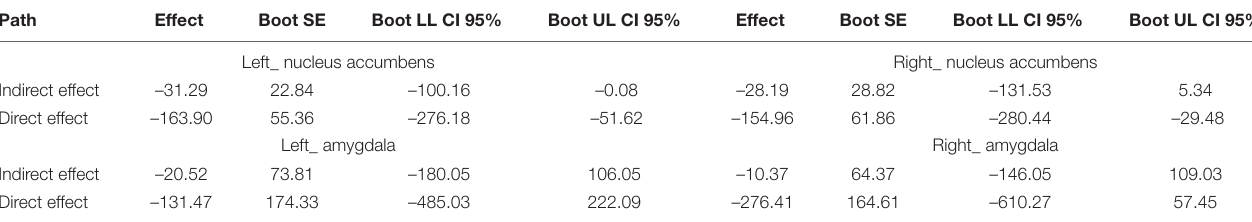
TABLE 4 | Statistic on indirect and direct effects (X = holistic thinking tendency, Mediator = reward sensitivity, Y = the volume of nucleus accumbens and amygdala, n = 39).